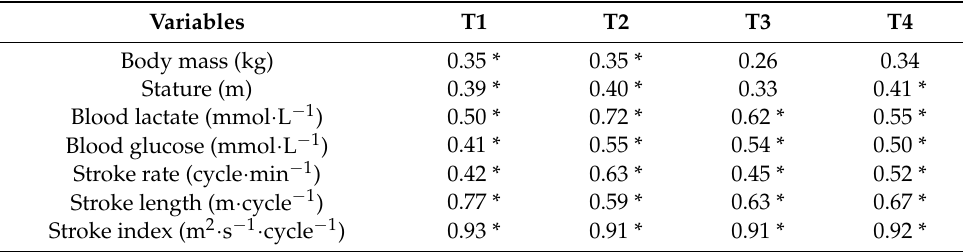
Table 4. Correlation values between anthropometric, physiological, and biomechanical variables and the 400 m front crawl performance at the four testing moments of the season.